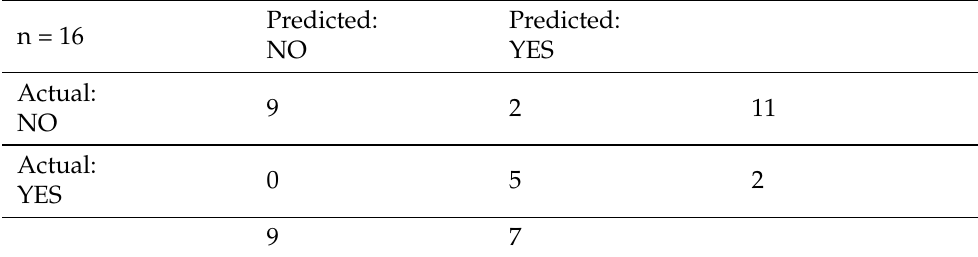
Table 4. Confusion matrix of the validation